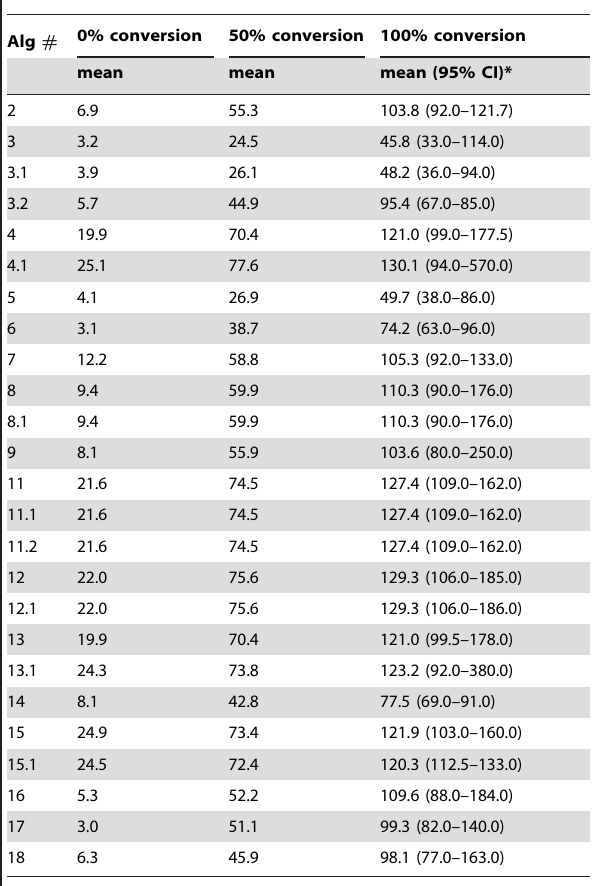
Table 2. Inno-Lia incident infection algorithms and the estimated time after infection in days at which 0%, 50% or 100% of the patients have converted from incident to older infection status.